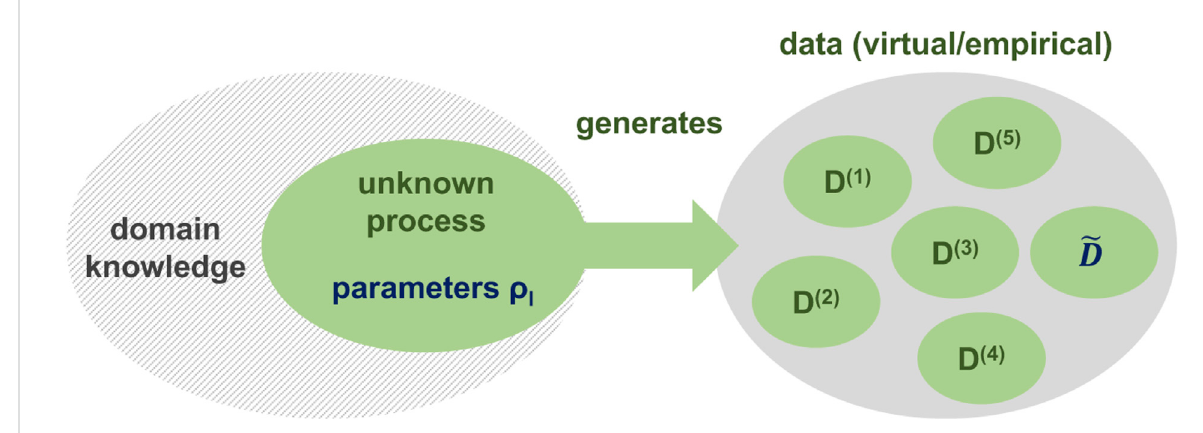
FIGURE 1 Statisticalinferenceattemptstoestimatefromobserveddata D ( k ) theunknownprocessparameters ρ l andasofyetunobserveddata ~ D .Bayesian inference exploits the fact that in many instances our model of the unknown process is embedded in a domain from which prior knowledge can be